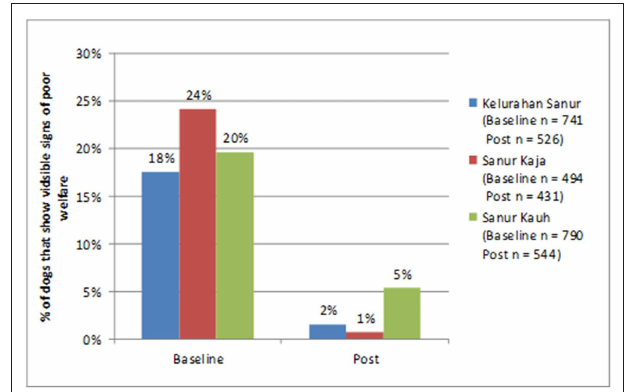
FIGURE 4 | Change in the percentage of dogs in a state of poor visible welfare at baseline and at their most recent visit.